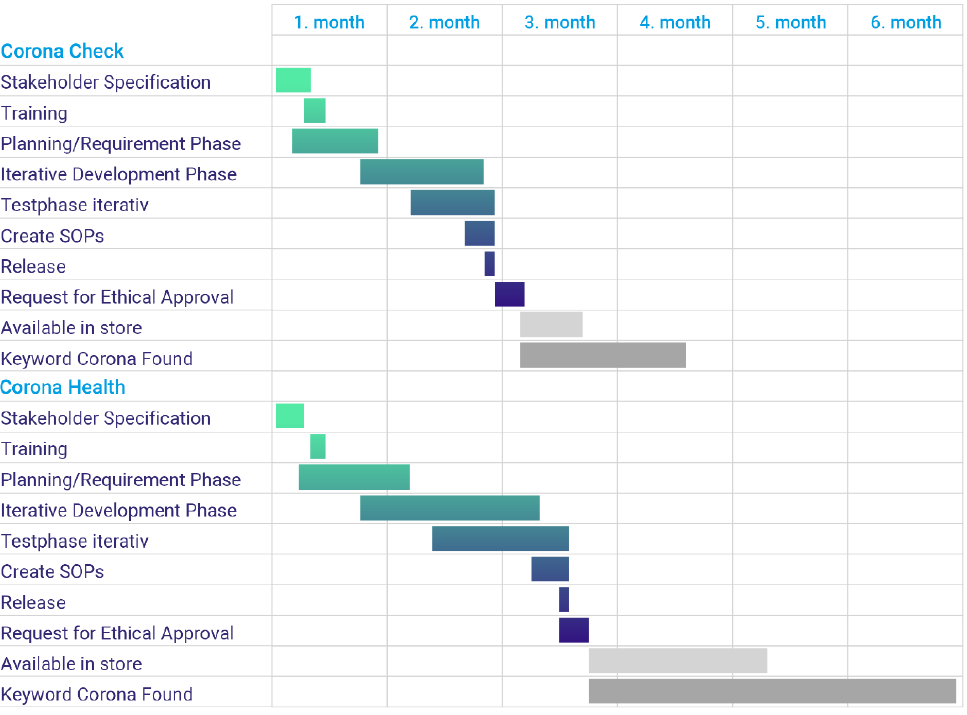
Figure 5. Development times for Corona Check and Corona